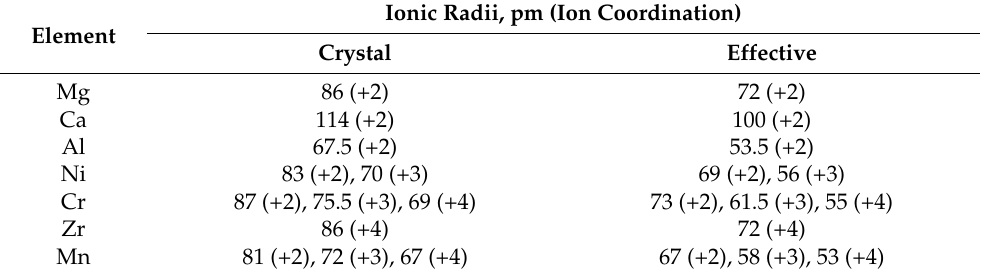
Table 2. Ionic radii of the selected elements